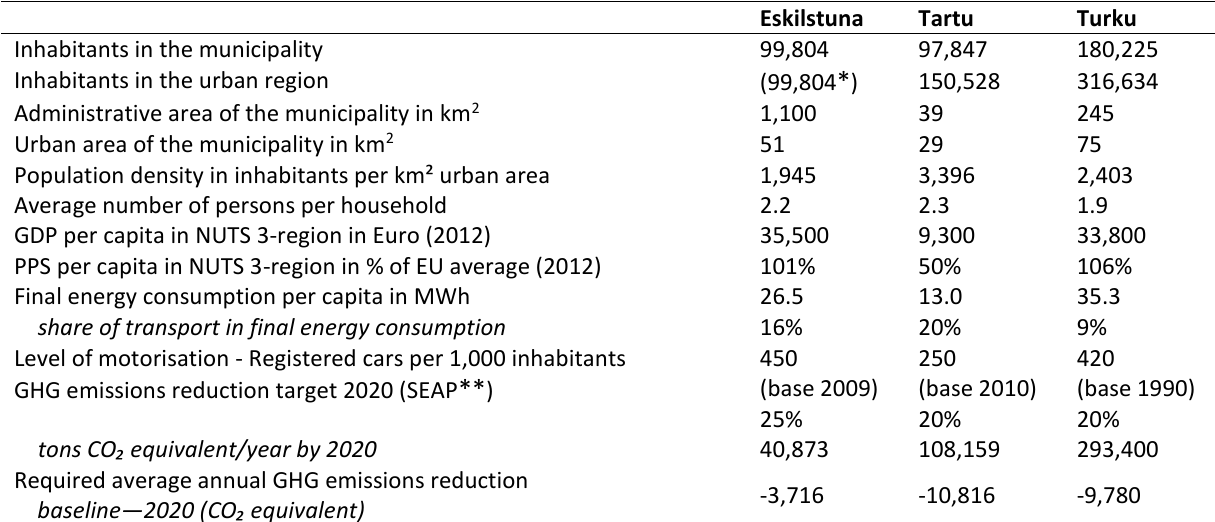
Table 1. Key figures of Eskilstuna, Turku and Tartu. Source: Eurostat, 2016; Giffinger, Hemis, Weninger, & Haindlmaier,